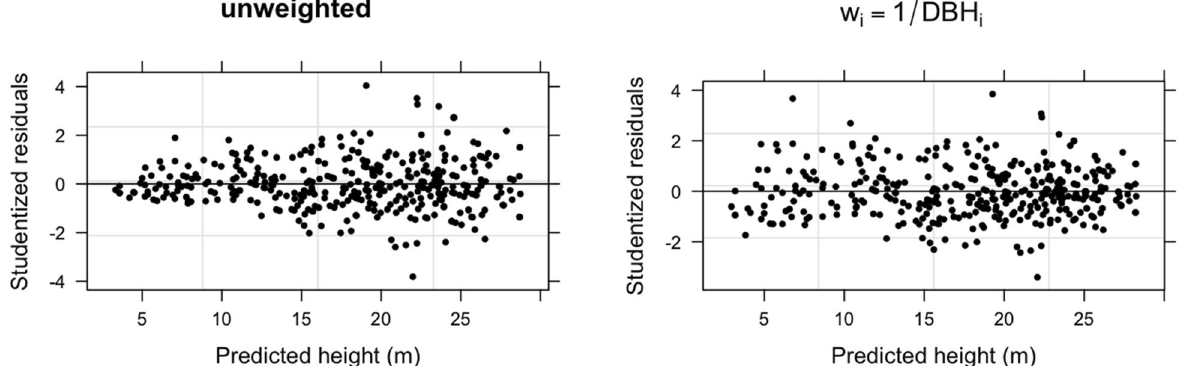
Fig. 11 The plot of studentized residuals against the predicted height for A. araucana . The studentized residuals were obtained by fitting model Eq. 1 without weighting (left) and with weighting factor w i = 1 ∕ DBH i